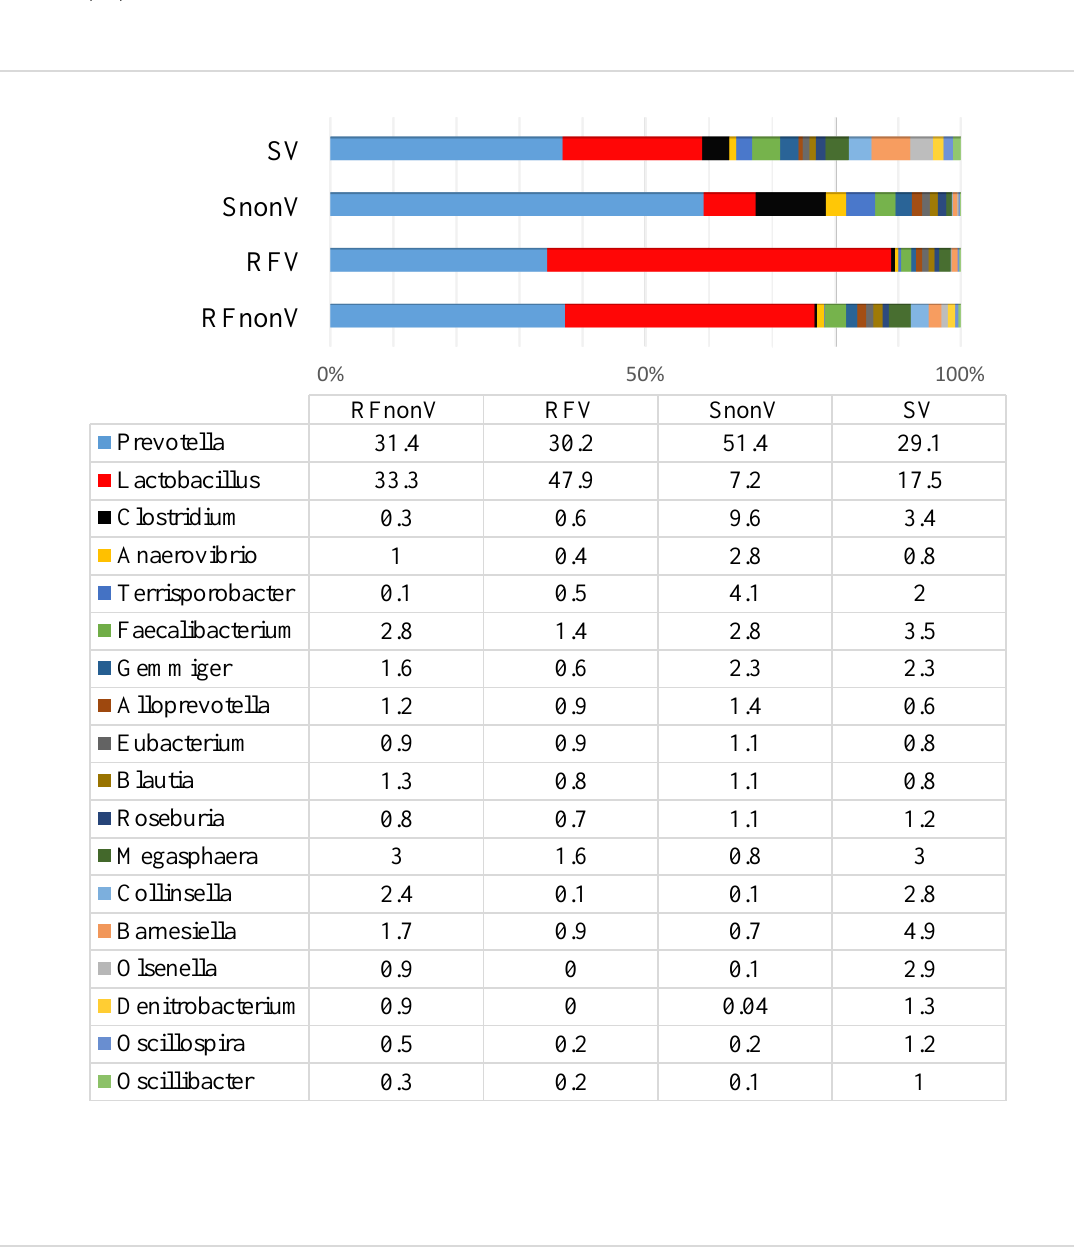
Figure 3. Microbial profiles (prevalence, %) at the genus level in pig faeces after experiment.